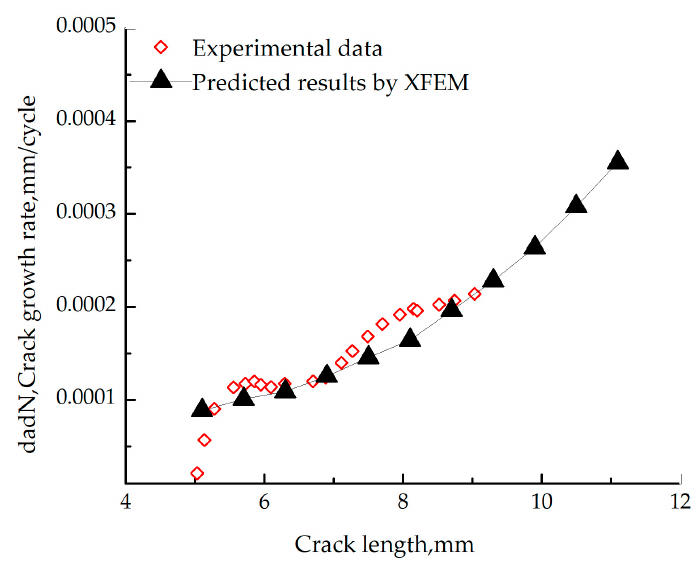
Figure 8. The comparison of numerical results and experimental data.